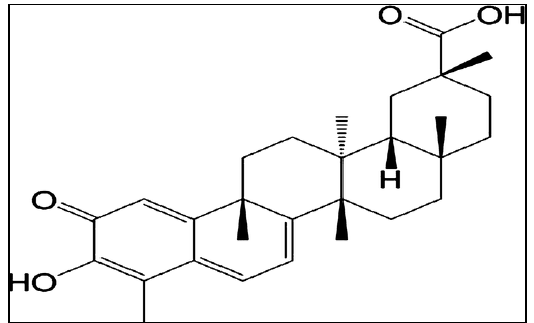
Figure 10. Chemical structure of celastrol (88)